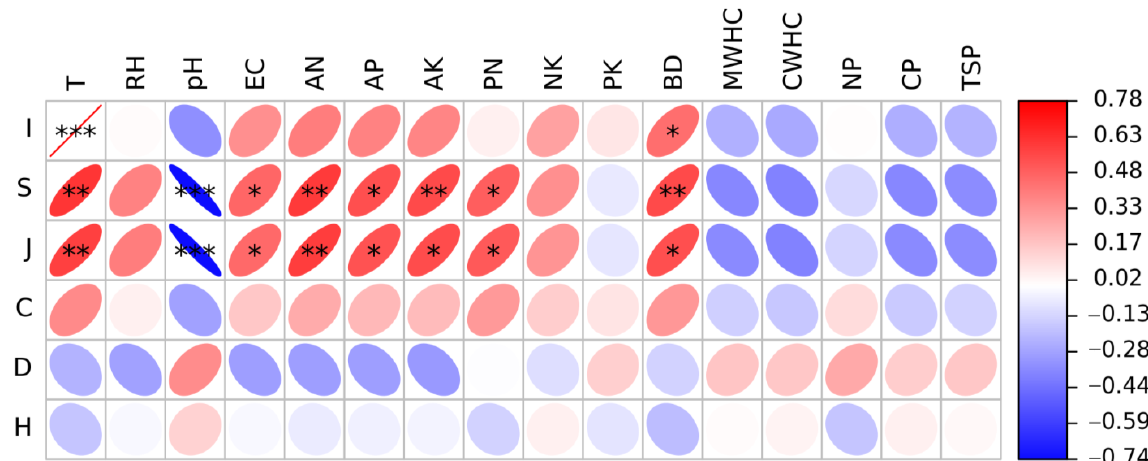
Figure 7. Pearson correlation coefficients between insect diversity and soil factors in the Guandi Mountain. Left column is the insect diversity index, where I means the numbers of insect individuals, S means the numbers of insect species, J means Pielou evenness index, C means Simpson index, D means Margalef richness index, H means Shannon–Wiener index. Top row is the physical and chemical properties of the soil, where T means soil temperature, RH means soil relative humidity, pH means soil pH, EC means soil electric conductivity, AN means soil available nitrogen, AP means soil available phosphorus, AK means soil available potassium, PN means the ratio of available phosphorus to available nitrogen, NK means the ratio of available nitrogen to available potassium, PK means the ratio of available phosphorus to available potassium, BD means soil bulk density, MWHC means soil maximum water holding capacity, CWHC means soil capillary water holding capacity, NP means soil noncapillary porosity, CP means soil capillary porosity, TSP means total soil porosity. The values in the scale bar represents the correlation coefficients. The color of the circle indicates the direction of the correlation, where red indicates positive correlation and blue indicates negative correlation, and the darker the color indicates stronger correlation. The size of the circle indicates the strength of the correlation, and the larger the circle, the stronger the correlation. * p < 0.05, ** p < 0.01, *** p < 0.001. 3.4. Effects of Environmental Variables on the Spatial Distribution and Diversity of Insect Communities along Altitudinal Gradients To further understand the main soil factors affecting the distribution of insect communities along the altitude gradient, redundancy analysis was performed to correlate the soil variables and insect taxa orders (Figure 8). All soil environmental variables accounted for 56.09% of the canonical eigenvalues in the insect groups with different elevation gradients. Insects with different altitude gradients had obvious clustering characteristics and showed different directions in the ordination biplot. Moreover, soil temperature was the major soil environmental variable influencing the distribution of insect groups along the altitude gradient. As an important insect community in the forest ecosystem at an altitude of 1600 m, the distribution of the Diptera and Coleoptera communities was positively correlated with soil temperature and negatively correlated with soil RH. The distribution of Hemiptera and Orthoptera along the altitude gradient was positively correlated with soil BD, EC, AN, AP, and AK, but negatively correlated with soil pH, MWHC, CWHC, NP, CP, and TSP. Additionally, increases in soil pH, MWHC, CWHC, NP, CP, and TSP may promote an increase in the Hymenoptera population. The soil properties selected in this study had a relatively marginal effect on